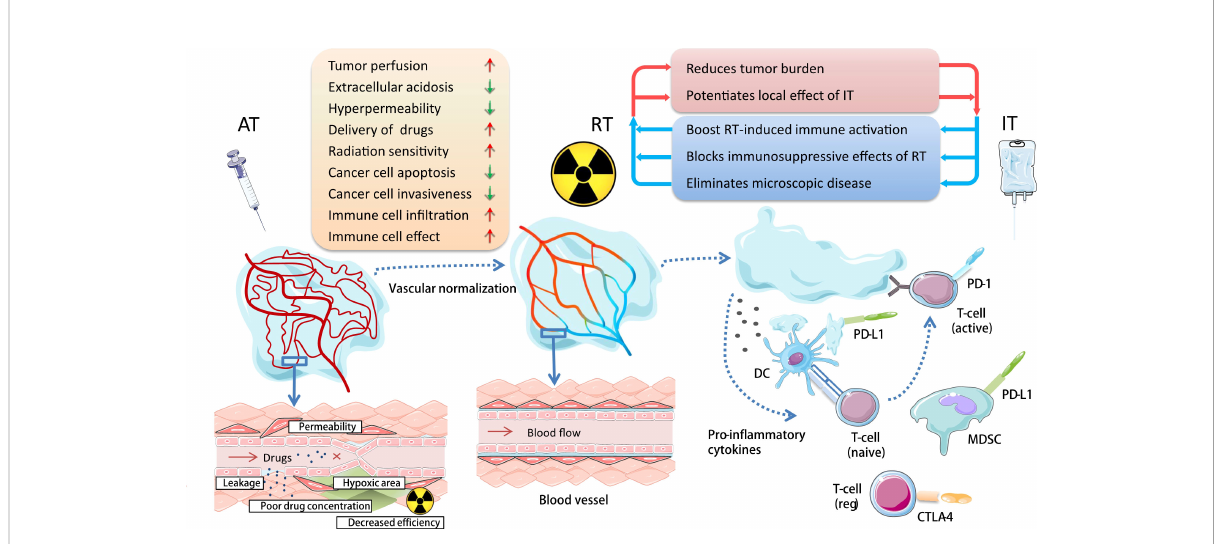
FIGURE 1 Basis for combining antiangiogenic therapy with radiotherapy and immunotherapy in cancer treatment. Antiangiogenic therapy can reconstruct and regulate the tumor vascular system; reduce leakage, tumor hypoxia, and tissue interstitial fl uid pressure; and improve drug delivery and balance tumor immune microenvironment, so as to make the tumor more sensitive to radioimmunotherapy. AT, antiangiogenic therapy; RT, radiotherapy; IT, immunotherapy; DC, dendritic cell; MDSC, myeloid-derived suppressor